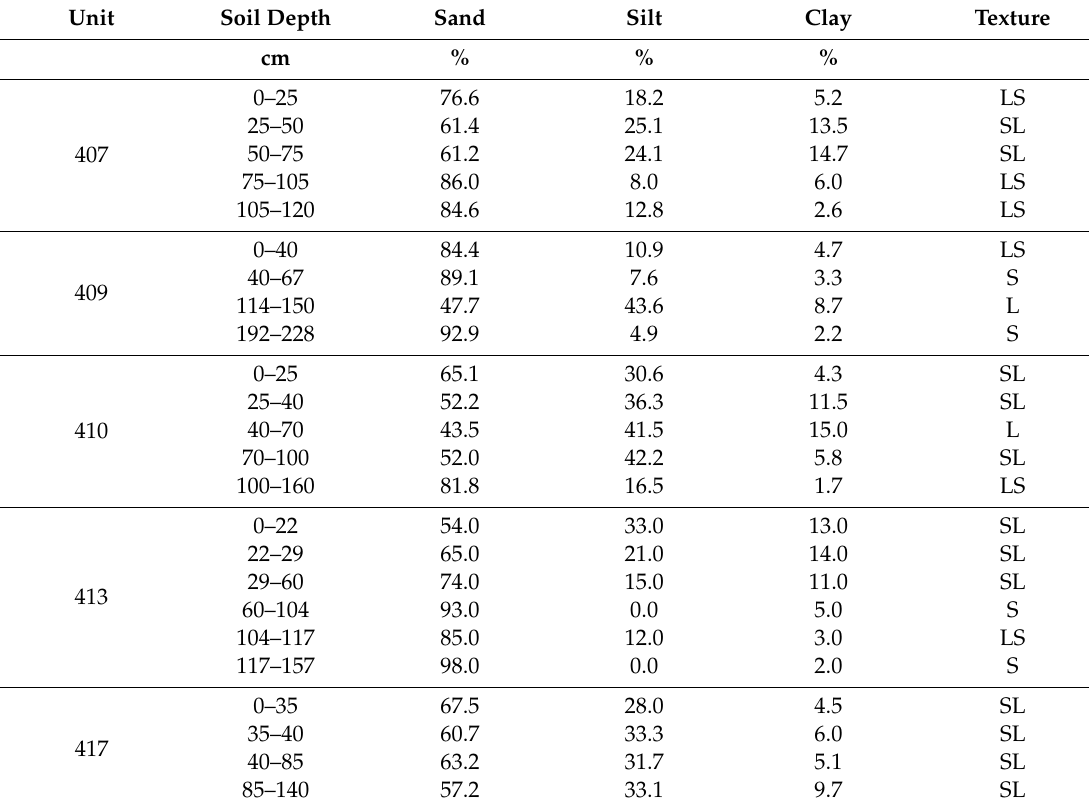
Table 1. Soil properties of the five prevalent soil units (407–417) within the pilot irrigation district [17]. For each horizon, the upper and lower limit, the sand, silt and clay content and the textural class according to USDA soil taxonomy are reported (LS: loamy sand; SL: sandy loam; S: sand; L: